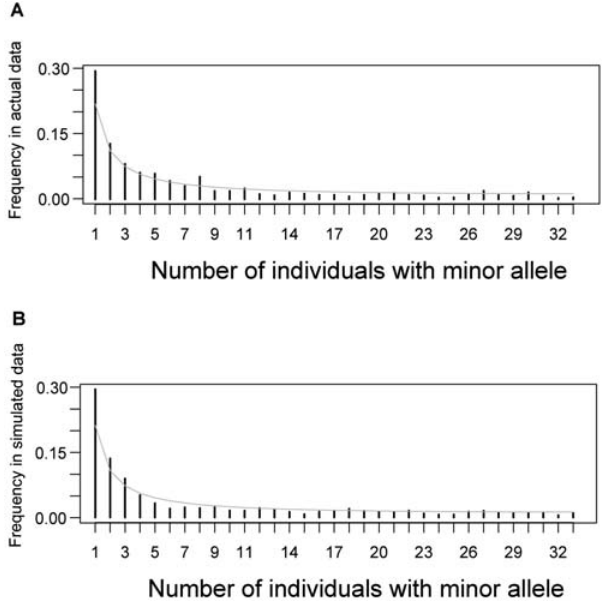
Figure 9. Frequency spectrum in actual and simulated data. Minor allele frequency spectra of empirical data and data simulated under the best-fitting model of spatial range expansion. Population growth followed the logistic model within each deme (see text for the other parameter settings). The solid line (grey) corresponds to the neutral folded frequency spectrum. (A) The empirical folded spectrum was computed from the 648 inter-genic and non-coding sequences. (B) The simulated spectrum was computed using the same number of neutral nucleotides as in the data. In simulations, expansion started 9,000 years ago from a potential origin north of the Black Sea (48 u N, 35 u E). Other locations from a large region around this potential origin yielded very similar simulated